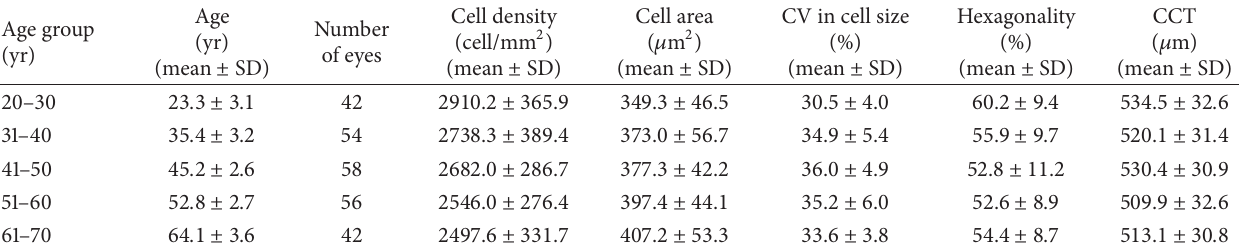
Table 1: Endothelial cell characteristics of the study population in different age